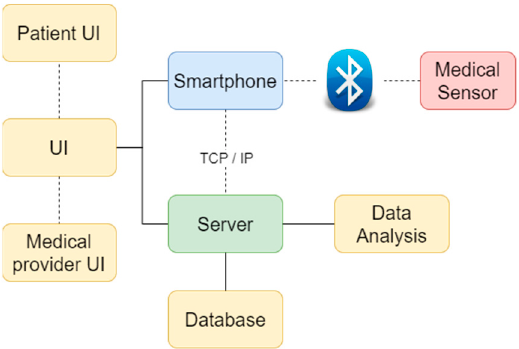
Figure 4. Block diagram for the Wireless Communication via Bluetooth (Device/Smartphone) and TCP/IP (Smartphone/Server).